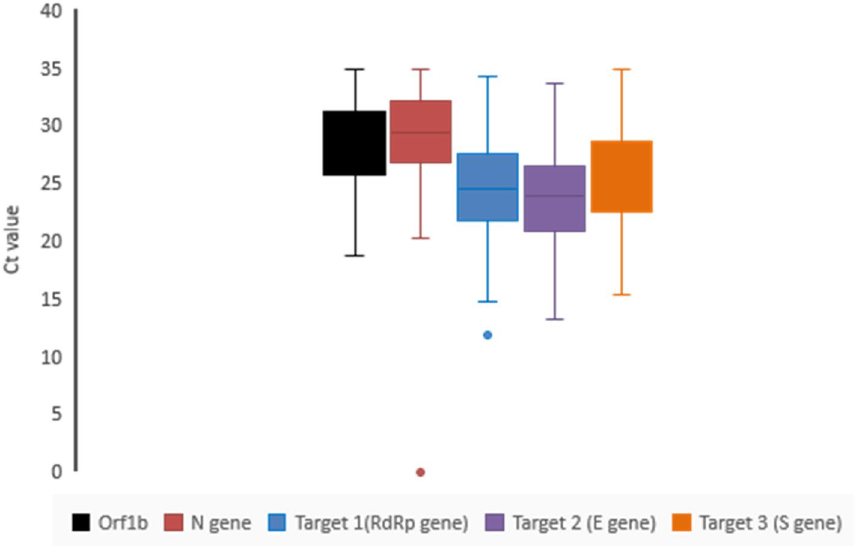
Figure 11. Box plot diagrams representing the C t values obtained for N = 100 samples previously tested SARS- CoV-2 positive with Meril Covid-19 detection kit. Dark bar: median; box: 25–75% interquartile; whiskers and dots: range in the box plot. Significant difference in C t values was observed upon testing with In house SARS- CoV-2 detection assay (Target 1, Target 2 and Target 3) when compared with that of Meril Covid-19 detection kit (Orf1b and N gene). Enhanced sensitivity of the in-house RT-PCR assay is evident from the plot showing comparable reduction in median C t value.